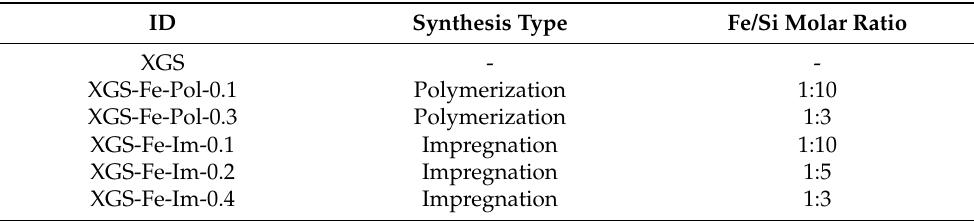
Table 1. Identification of the synthesized materials and main synthesis